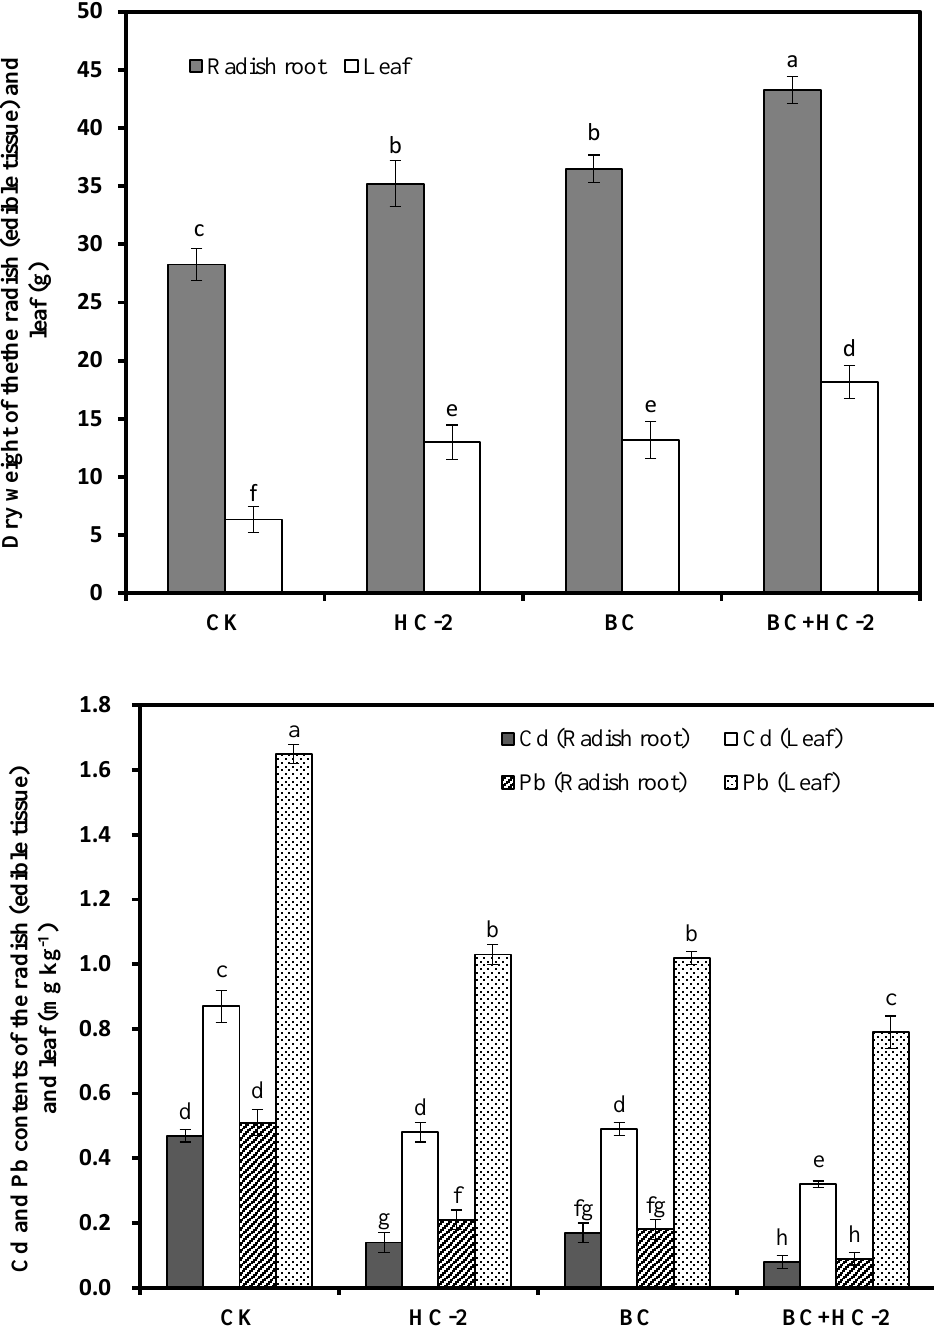
Figure 2. E ff ects of strain HC-2, BC, and BC + HC-2 on the dry weight and heavy metal accumulation of Figure 2. Effects of strain HC-2, BC, and BC+HC-2 on the dry weight and heavy metal accumulation the radish roots and leaf. Error bars are ± standard error ( n = 3). Data followed by the di ff erent letters of the radish roots and leaf. Error bars are ± standard error (n = 3). Data followed by the different (a–h) are significantly di ff erent ( p < 0.05) according to Tukey’s letters (a–h) are significantly different ( p < 0.05) according to Tukey’s test.